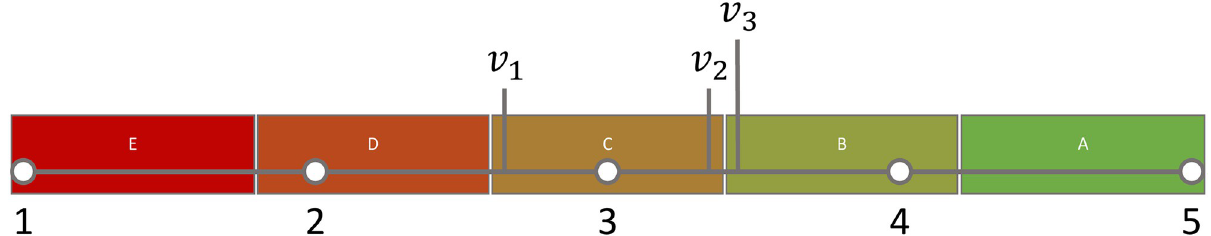
Fig 3. A diagram of the MOS scale (numbers 1 to 5), and the class labels used in [9] and [10] for fine-tuning the network represented by the bins E to A. Each bin interval is highlighted by a different color (red to green). The video MOS values are binned according to the five intervals (E to A) to form the target classes used during training. The quantization of MOS values to the five bins reduces labelling precision, which makes training more challenging. For instance, given three videos v 1 , v 2 , and v 3 at adjacent class boundaries, the difficulty of the classification task becomes apparent. The perceived quality of v 2 and v 3 is very similar, but they are split into different classes. Conversely, v 1 and v 2 have a less similar quality than the previous pair, but they are grouped into the same